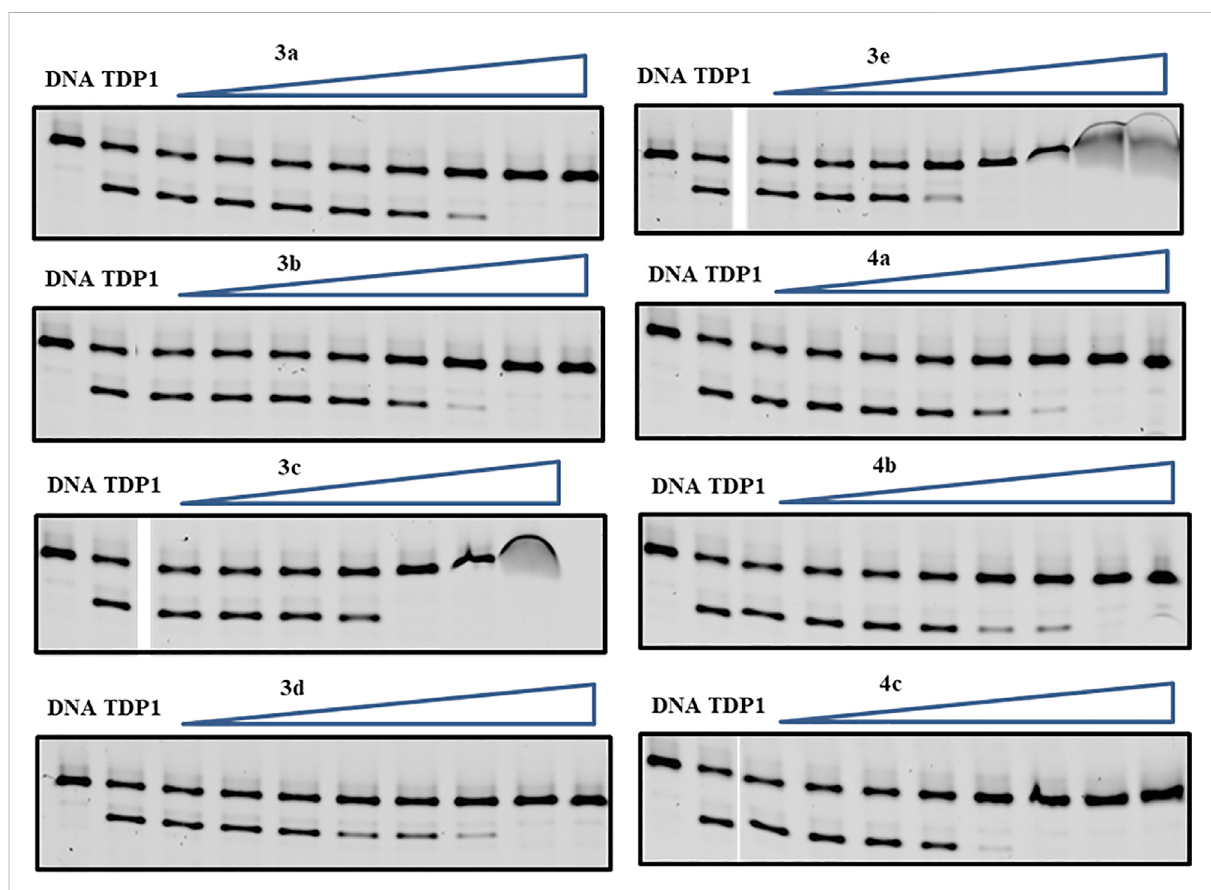
FIGURE 4 Representative gels for inhibition of full-length TDP1-catalyzed hydrolysis by phenylphosphonic acids 3a — 3e and benzylphosphonic acids 4a — 4c . In each gel: lane 1, N14Y only; lane 2, N14Y and TDP1; lanes 3 – 10, 3-fold serial dilution of drugs from 12 μ M to 27 mM except for 3c from 12 μ M to 9 mM. The crescent vague bands in 3c and 3e are caused by the poor drug solubility in these high